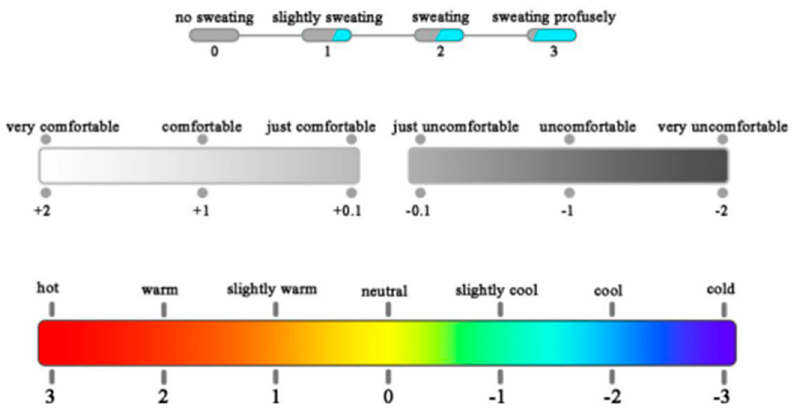
Figure 4. Scales for SFI, TCV, and